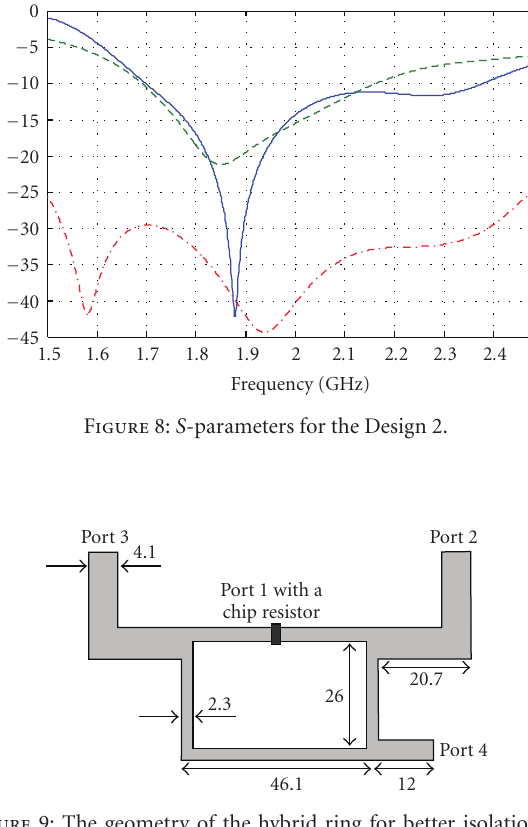
Figure 9: The geometry of the hybrid ring for better isolation in Design